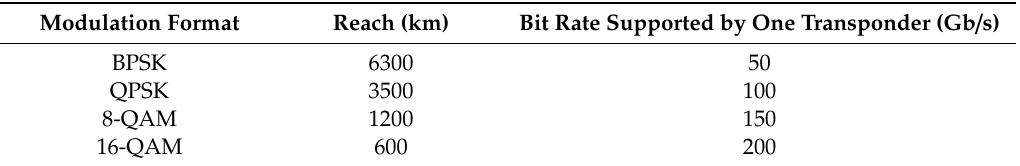
Table 1. Transmission reaches (km) and supported bit rates (Gb/s) per one transponder for considered modulation formats.